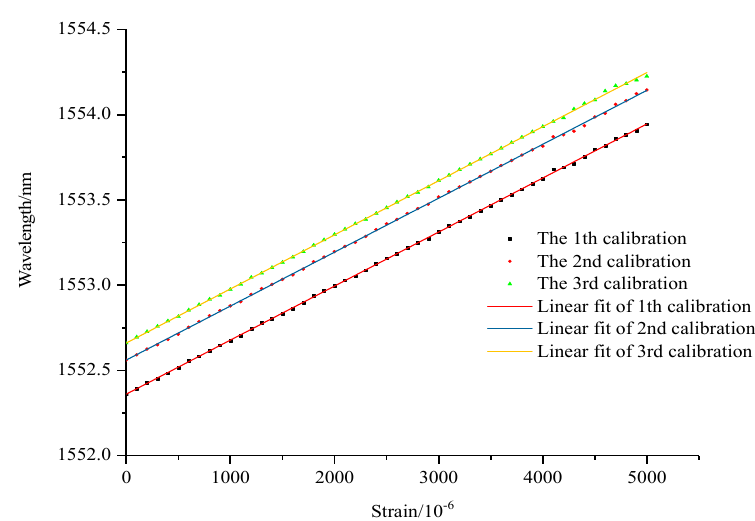
Figure 11. Calibration of 2 times range sensor.